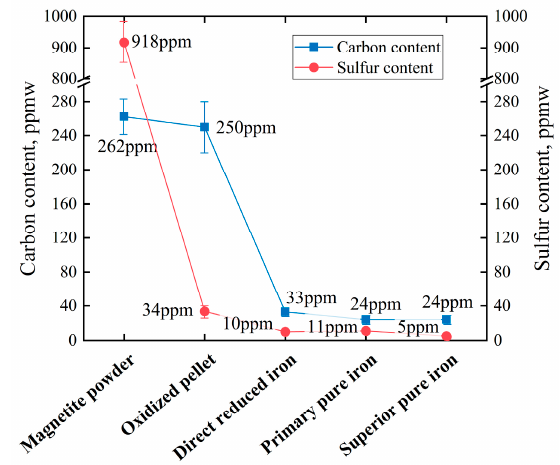
Figure 2. The changes in carbon and sulfur content in each step.